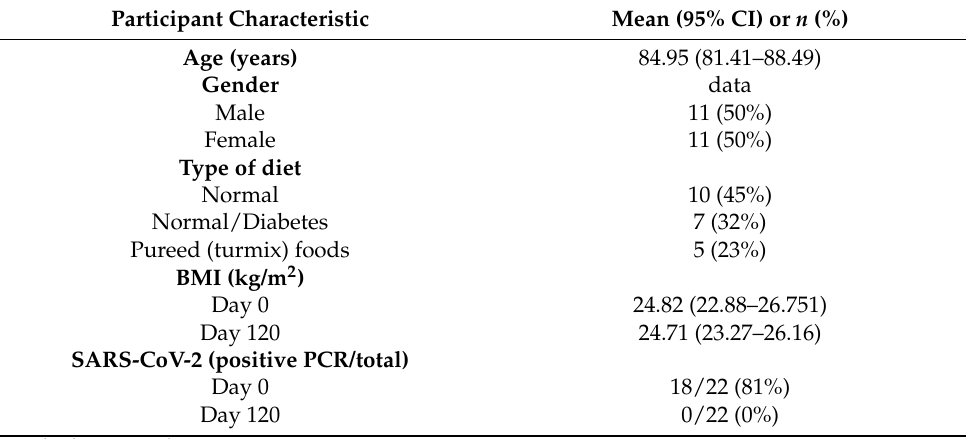
Table 1. Main characteristics of the elderly population that completed the trial ( n =